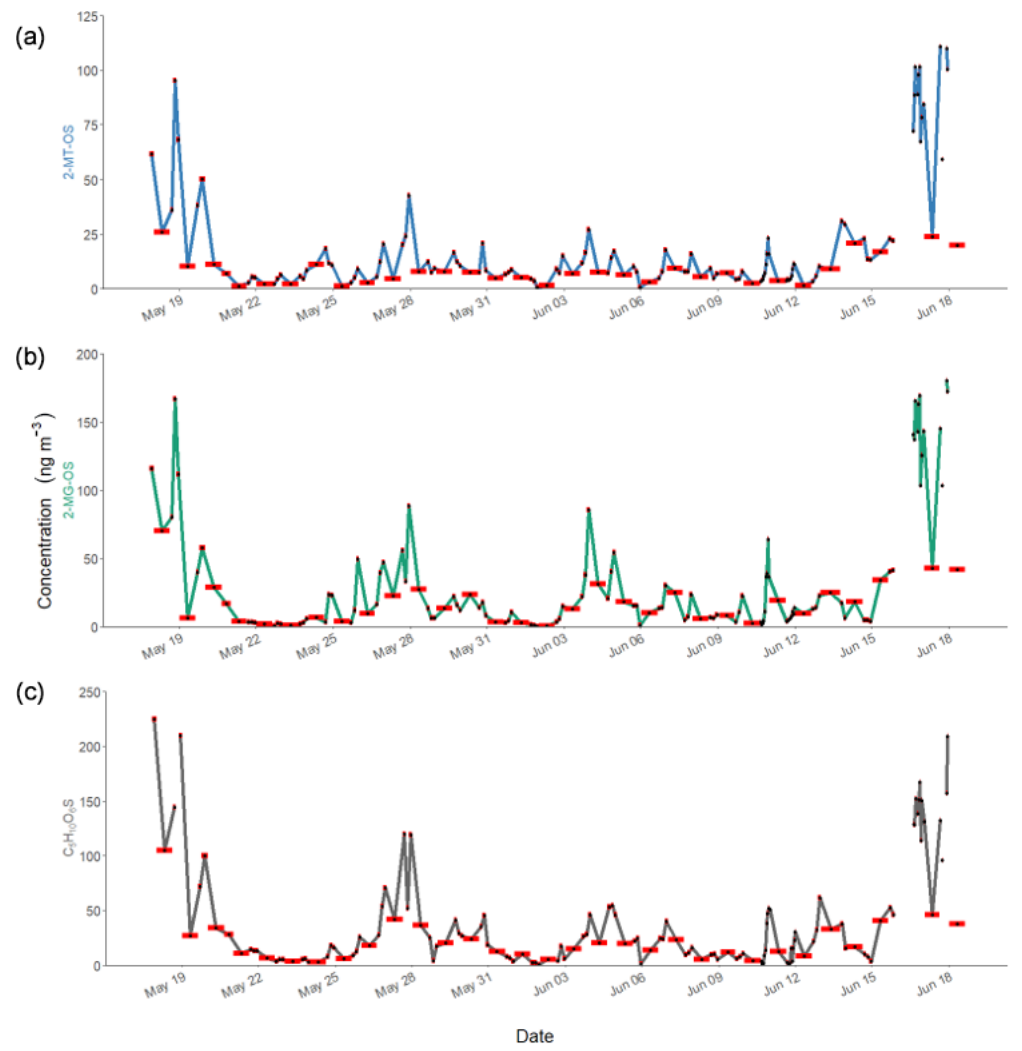
Figure 6. Time series of observed concentrations of iSOA tracers in Beijing during APHH for (a) 2-MT-OS (C 5 H 12 O 7 S), (b) 2-MG-OS (C 4 H 8 O 7 S) and (c) C 5 H 10 SO 6 . The red bars indicate the length of the sampling period. The individual sample times will be given in the accompanying dataset (https://doi.org/10.15124/7c1a54dd-ce72-4b1a-bed1-812cf25bc407; Hamilton and Bryant, 2019). Table 4. Comparison of iSOA tracer concentrations and ratios from previous studies in the Amazon, the Southeastern US and China. Mean concentration (ngm − 3 ) Ratio low to high NO Ratio CHO : CHOS Location 2-MT 2-MT-OS 2-MG